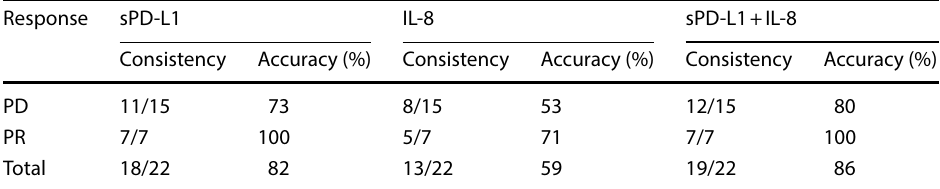
Table 3 Accuracy of functional sPD-L1 and IL-8 in efficacy evaluation during anti-PD-1